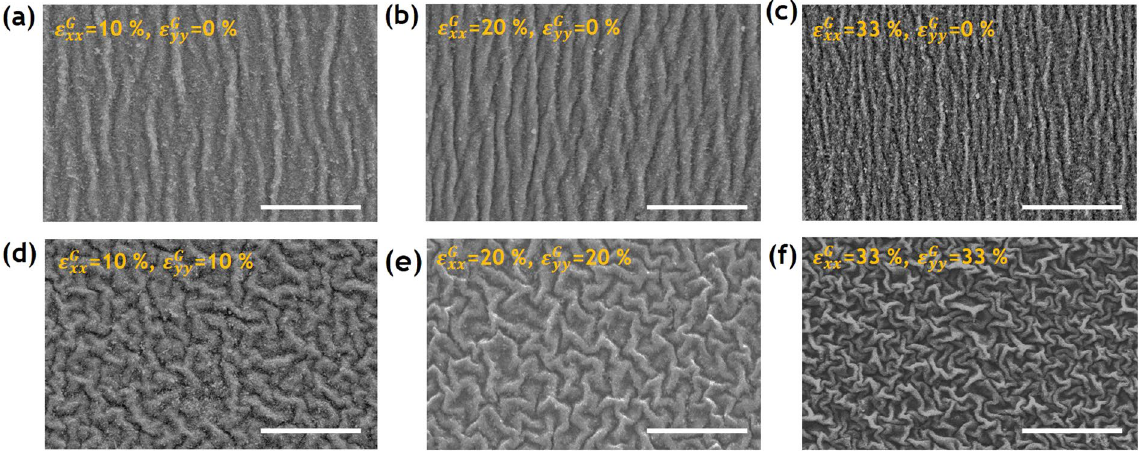
Figure 2. SEM imagery of the wrinkled electrode showing one- and two-directional ripple patterns due to the buckling of the carbon electrode: uni-axially wrinkled surfaces produced by compressive strains of ( a ) 10, ( b ) 20, and ( c ) 33%; bi-axially wrinkled surfaces produced by compressive strains of ( d ) 10, ( e ) 20, and ( f ) 33%, in both the x- and y- directions (Scale bar = 20 μ